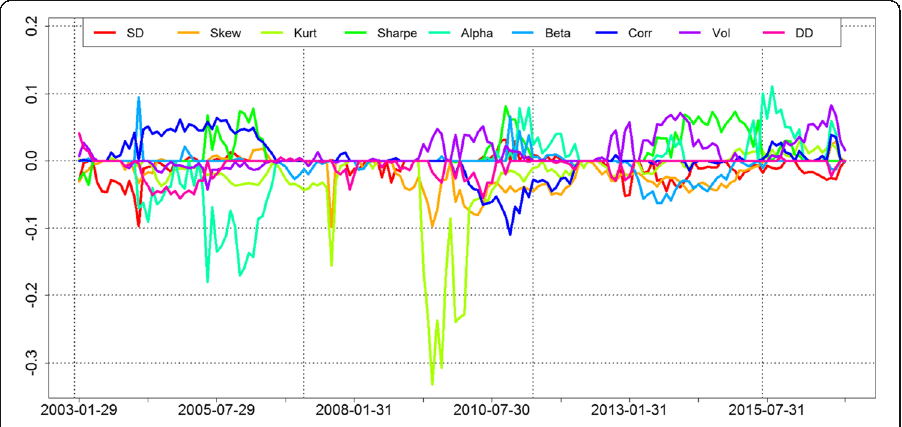
Fig. 5 Time series of the coefficients for statistics based features. This figure plots the coefficients for each statistics based features at each time